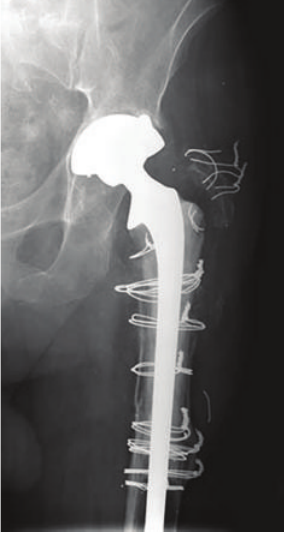
Figure 2: A radiograph 17 years after proximal femoral allograft (reprinted from Safir et al.